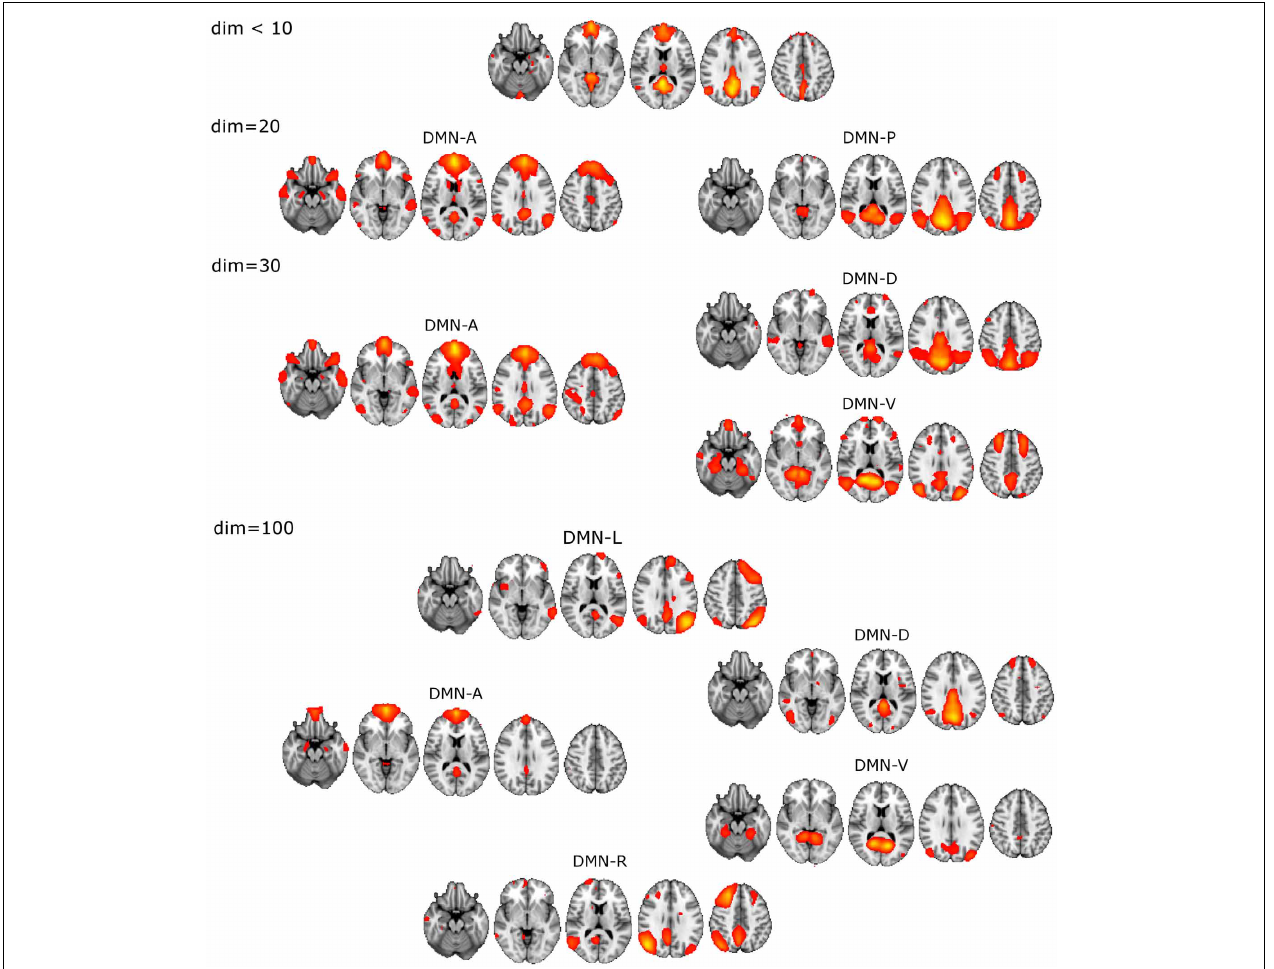
FIGURE 1 | Illustration of the DMN division into distinct DM-SNs presented across the studied ICA dimensionalities of 20, 30, and 100. First at dim = 20 the original low model order single DMN is split into